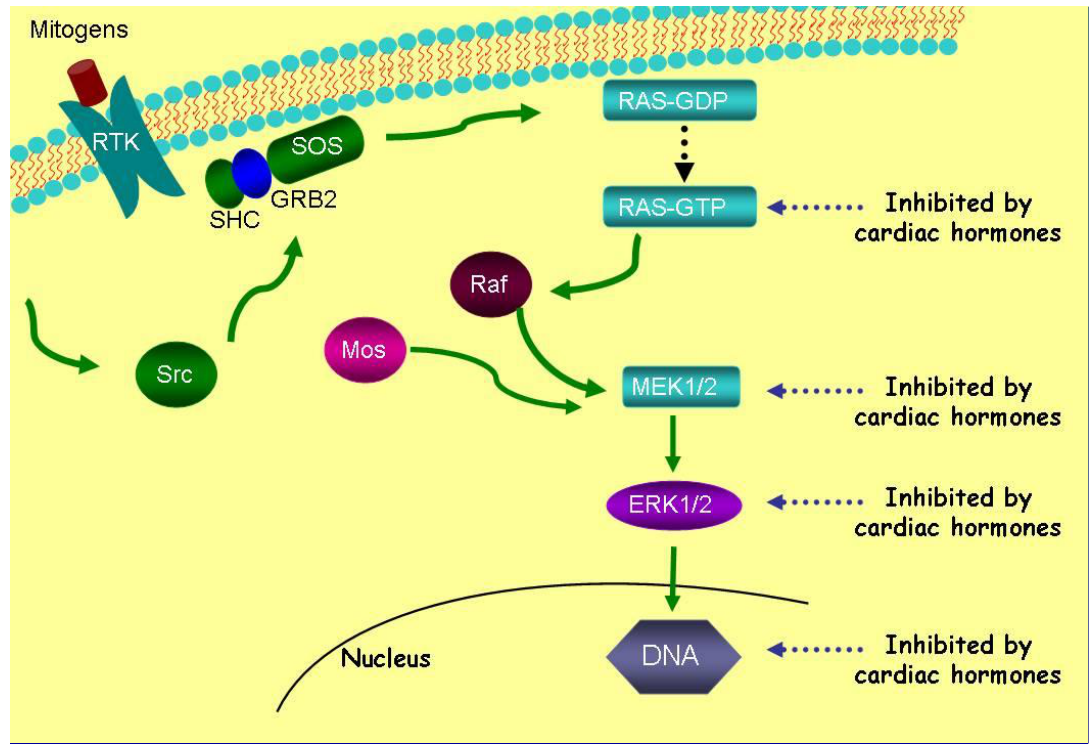
Figure 4. Cardiac hormones inhibit five metabolic targets, i.e. , Ras-GTP, MEK 1/2, and ERK 1/2 kinases of the Ras-MEK 1/2-ERK 1/2 kinase cascade by 95-98%. They are also strong inhibitors ( i.e. , 91%) of DNA synthesis within cancer cells. Reprinted with permission from